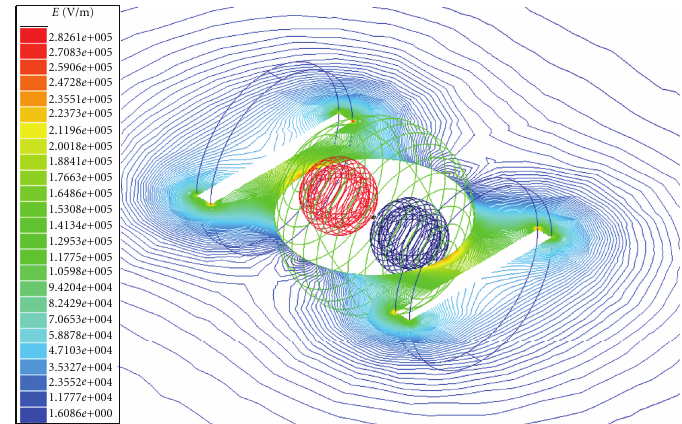
Figure 2: Electric field distribution for breast lobe tissue with normal cells (plane electrodes).